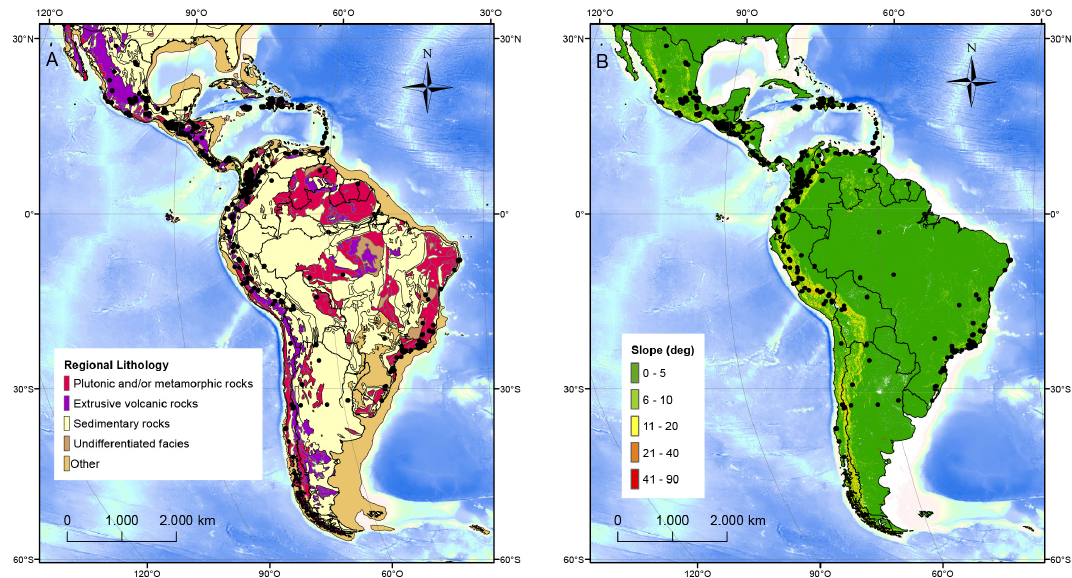
Figure 7. Spatial distribution of landslides (black dots) on top of (a) geological map (Geological Map of the World, CGMW, 2010) and (b) slope map (STRM30 database).